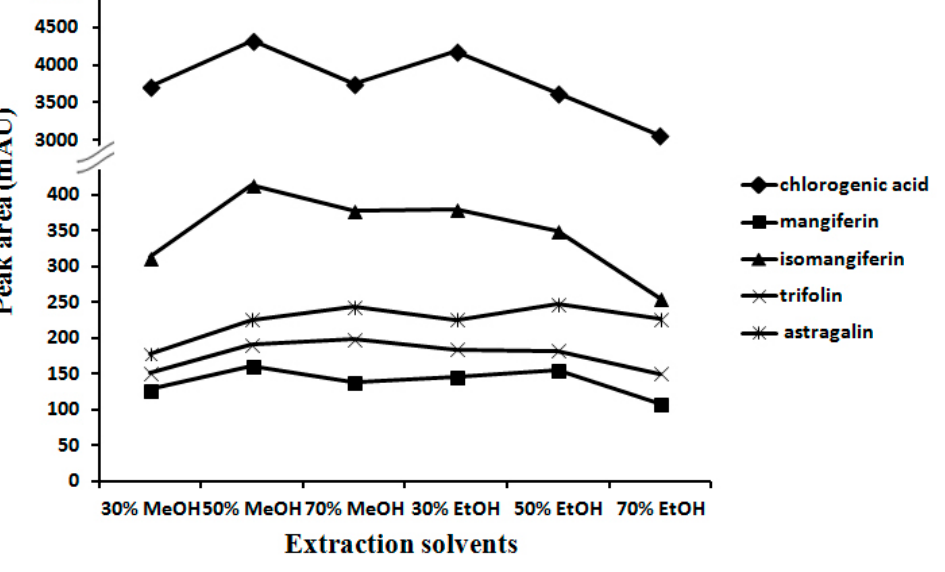
Figure3. Optimization of extraction solvents.